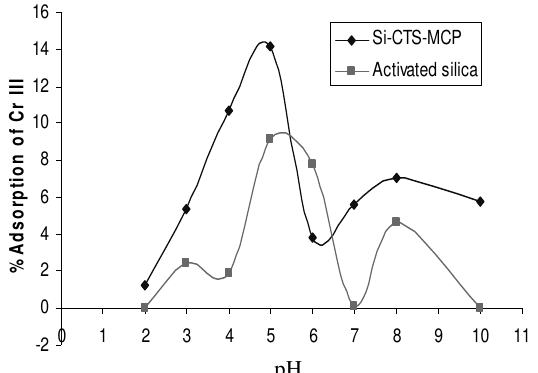
Figure 7. Effect of pH solution on percentage of chromium(III) adsorbed onto Si-CTS-MCP and activated silica.